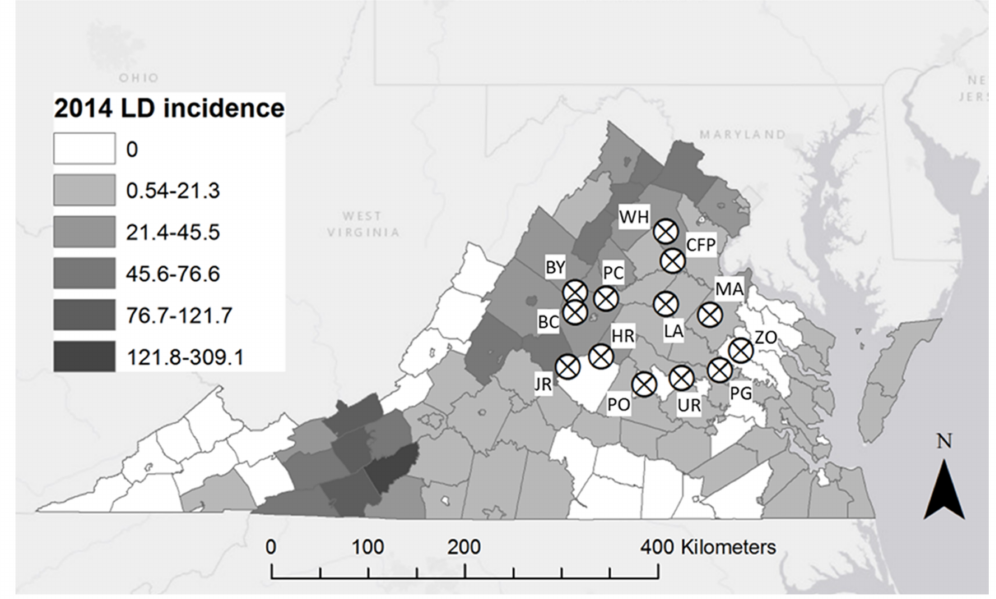
Figure 1. Map of study sites (circles) throughout central Virginia sampled for I. scapularis , A. americanum , and D. variabilis in May and June 2014. Counties are shaded based on 2014 Lyme